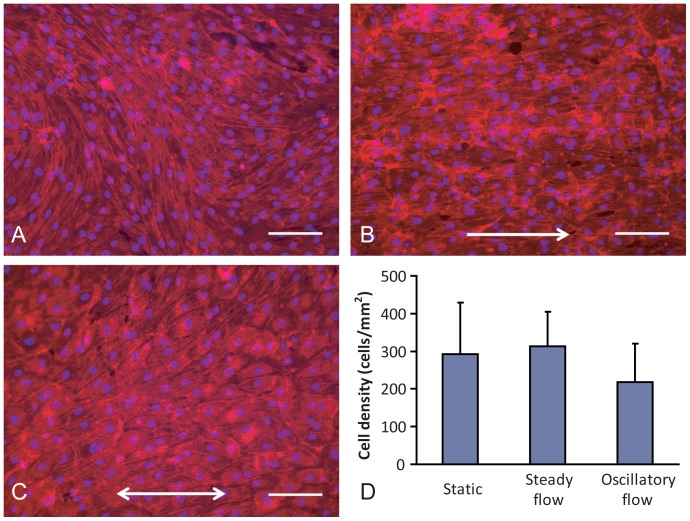
Cell coverage and quantification.Representative fluorescent images of EOCs seeded on ePTFE grafts for 24hrs followed by 24hrs of continued static culture (A), 10 dynes/cm2 steady fluid shear stress (B), or 0±10 dynes/cm2 at 1 Hz oscillatory shear stress (C). EOCs without flow conditioning had either a cobblestone morphology or random cell alignment. Steady shear stress imparted an elongated cell morphology, with cells aligning in the direction of flow. Oscillatory shear stress induced a rounded morphology. Scale bar equals 100 µm. Arrows indicate the direction of flow stimulation. Actin filaments were stained red with nuclei in blue. Cell density (D), as determined by the PicoGreen assay for DNA quantification, indicated no significant differences between treatment groups. ANOVA, p = 0.32. N≥6.